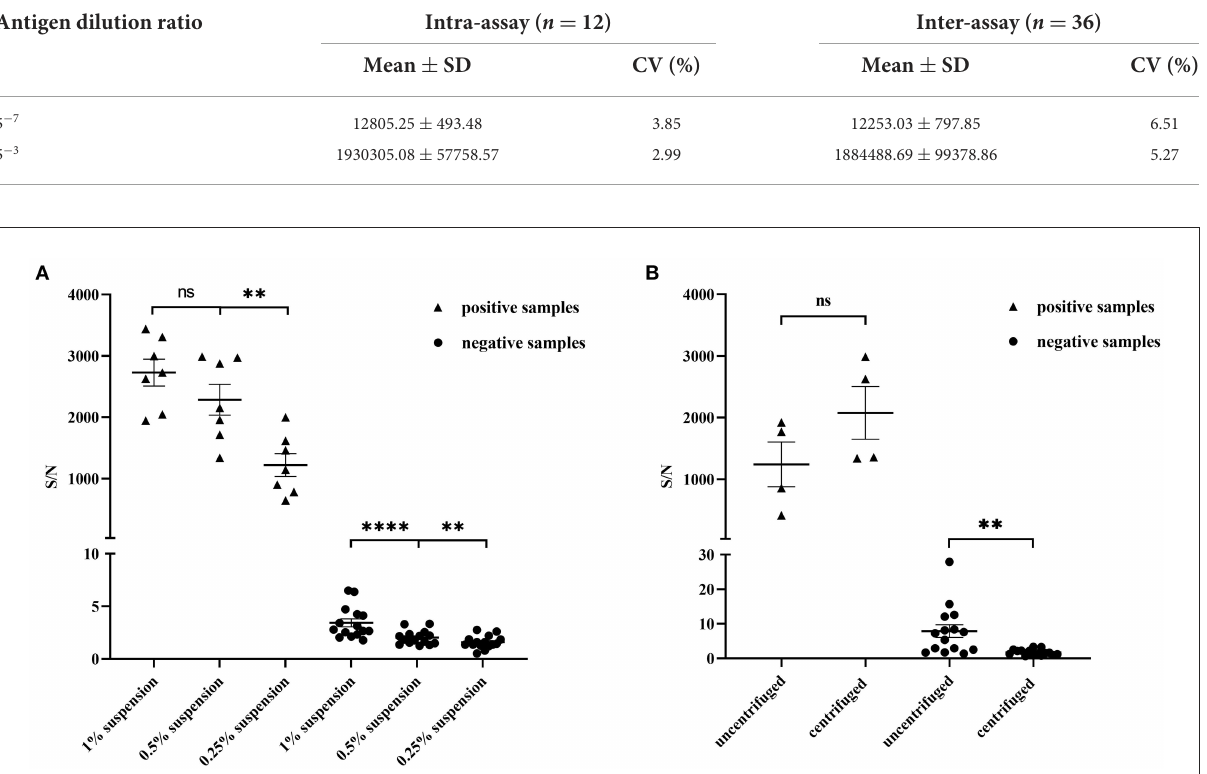
TABLE 1 Intra- and inter-assay coefficients of variation (CV).